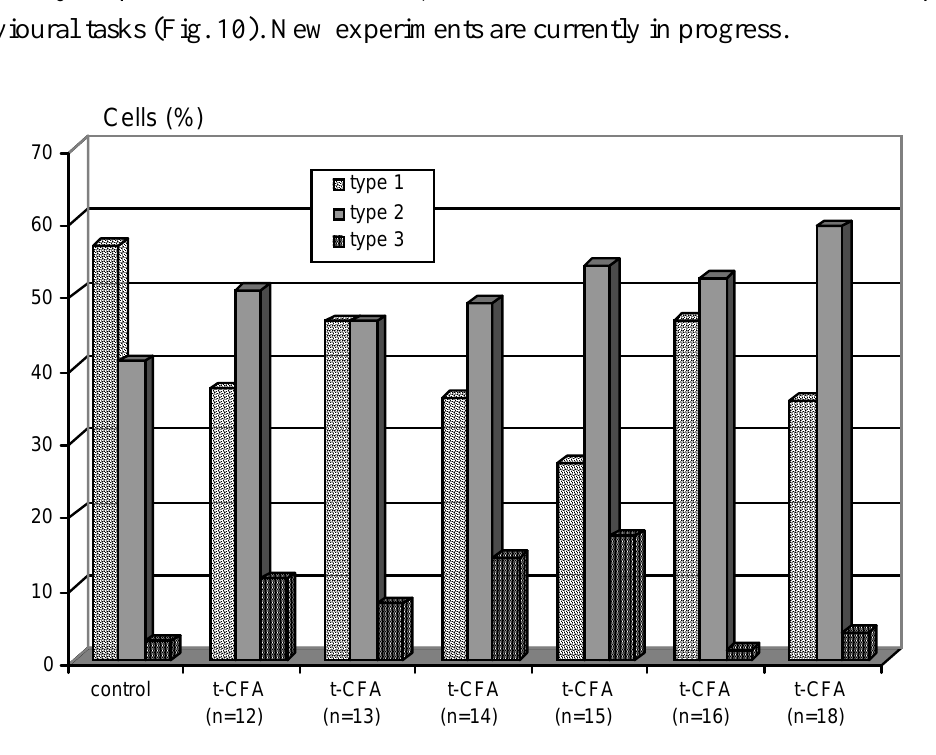
Figure 9. Effect of t-CFAs on neurite outgrowth. Six t-CFAs bearing an aliphatic side chain that ranged from 12 to 18 carbon atoms were tested at 100 nM. After morphometric analysis, neurons were divided into three categories according to their total neurite length (Type 1 (cid:148)(cid:20)(cid:19)(cid:19)(cid:3) µ m; Type 2 101-200 µ m; Type 3 201-300 µ m). Note that t-CFA (n=14) and (n=15) are the most potent molecules in stimulating neurite sprouting. The data correspond to two pooled independent experiments (50-70 cells /